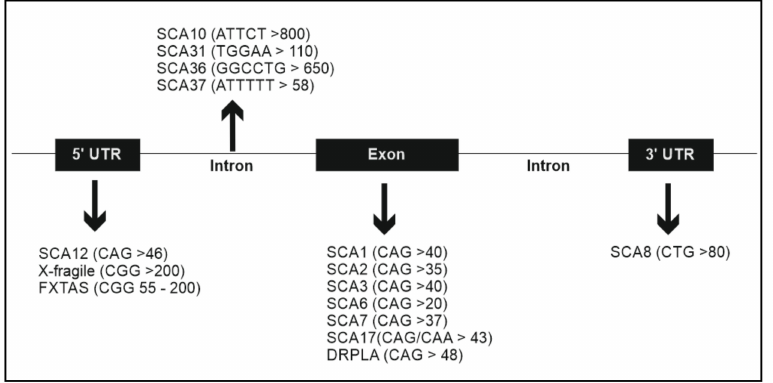
Figure 1. Repeat expansions in different